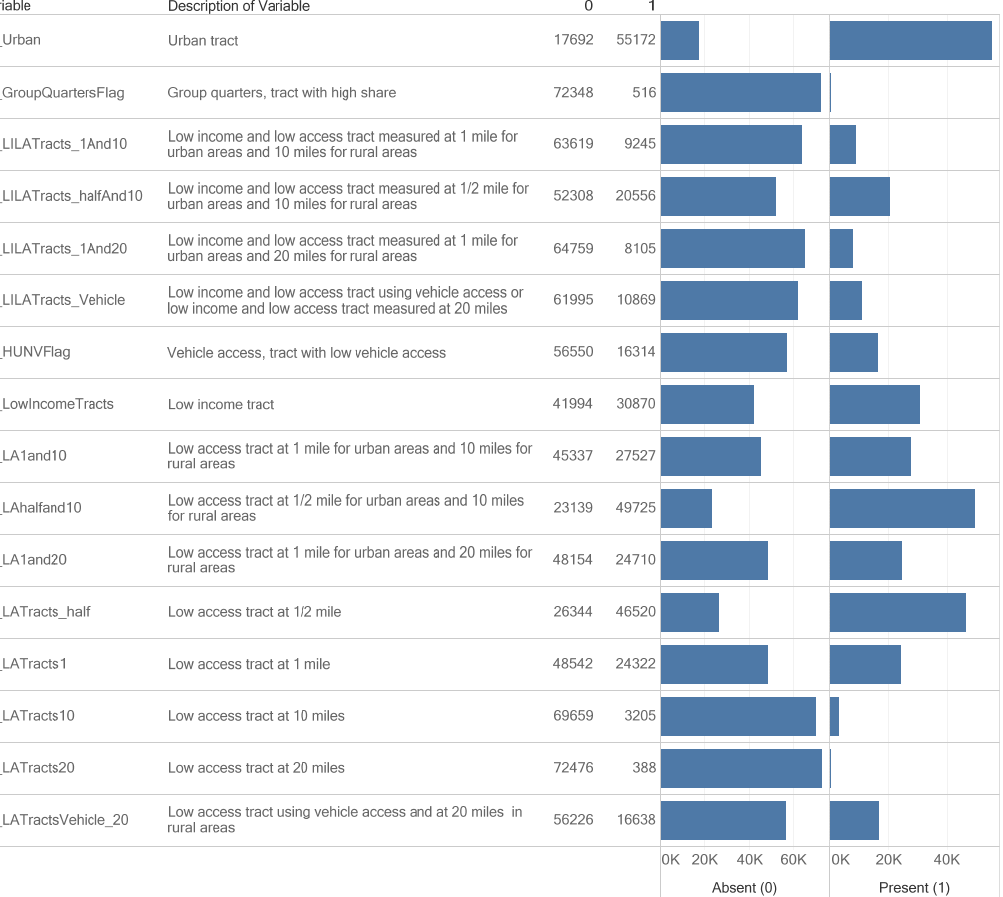
Figure 2. Comparison of counts of census tracts for 16 variables encoding food access measures. The knowledge visualization integrates enclosure table and bar graph to support attention and new insights on the counts of census tracts in two categories of presence or absence of the variable. Variables 02_GroupQuartersFlag and 15_LATracts20 have less than 1000 census tracts.